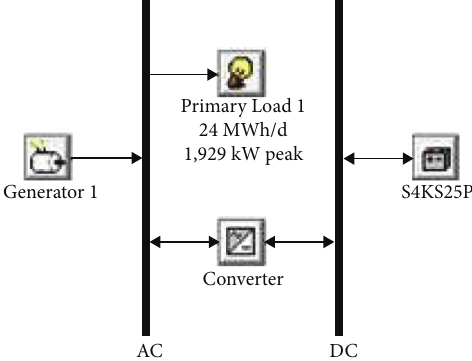
Figure 5: The landfill simulation with capacity of 1MW.